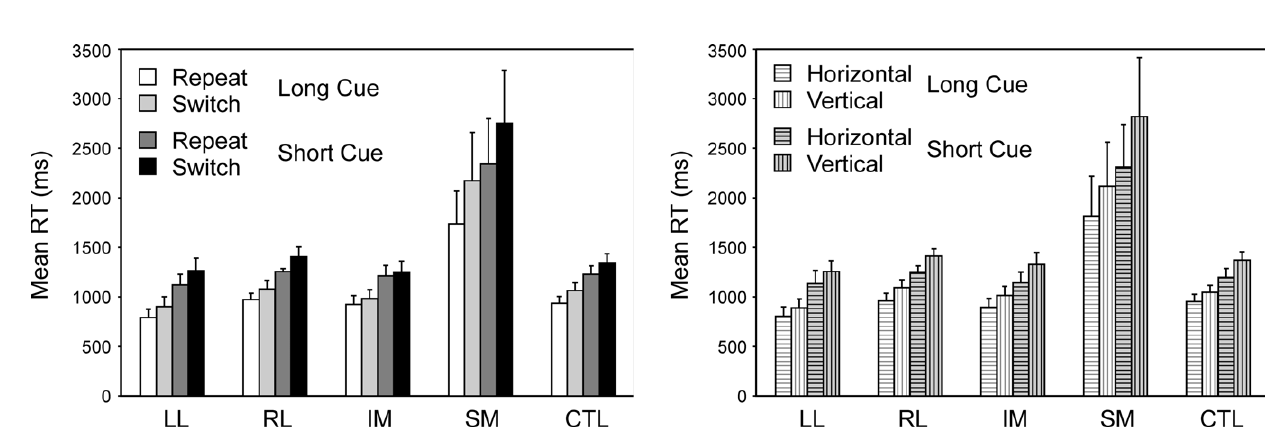
Figure 4. Switch vs. Repeat. Mean reaction times and standard errors for the four patient groups and the controls on Repeat and Switch trials in the Long Cue and Short Cue task conditions.